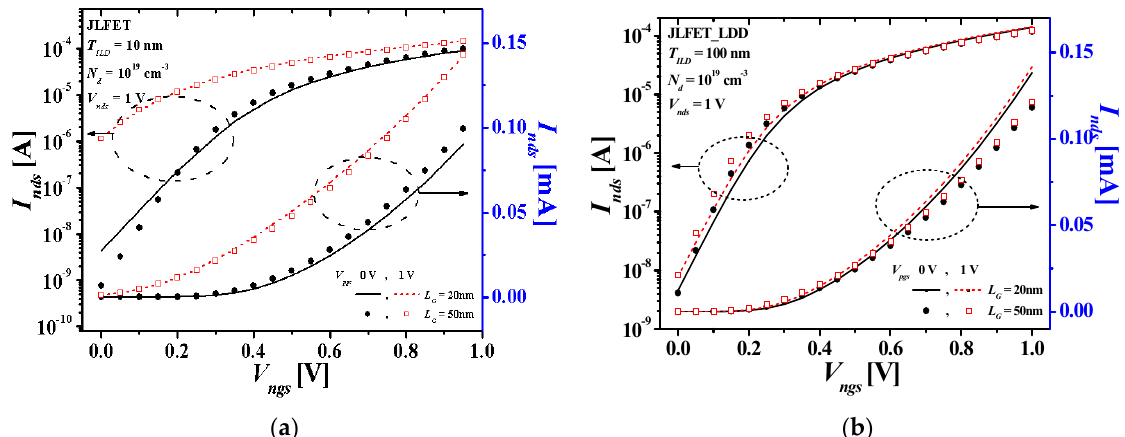
Figure 3. Current-voltage characteristics of the top N-type junctionless field-effect transistor (JLFET). ( a ) I nds -V ngs characteristics at V pgs = 0 (solid lines and filed circles) and 1 V (dotted lines and empty squares) in the case of ILD = 10 nm and ( b ) I nds -V ngs characteristics at V pgs = 0 (solid lines and filled circles) and 1 V (dotted lines and empty squares) in the case of T ILD = 100 nm. The lines and symbols denote L G = 20 nm and 50 nm, respectively. The channel width W = 0.2 μ m.